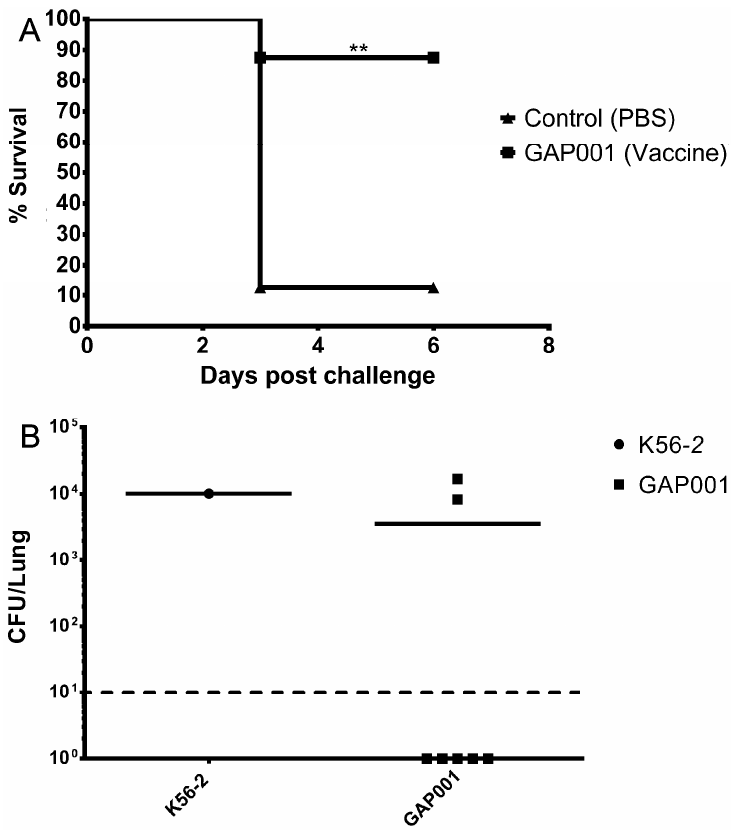
Figure 4. Immunization with GAP001 protects against challenge with B. cenocepacia. BALB/c mice immunized with 5 × 10 7 CFU of GAP001 showed protection against the challenge with B. cenocepacia and compared with the control group (PBS). ( A ) Survival curves for the vaccinated (squares) and non-vaccinated (triangles) mice. ( B ) Bacterial loads at 6 days post infection for the vaccinated (squares) and non-vaccinated (triangles) mice. The limit of detection was 10 CFU/lung (horizontal dotted line). The Kaplan–Meier method was used and significant differences ( p ≤ 0.05) were calculated via a log rank test. Table 4. Serum antibody response of BALB/c mice i.n. vaccinated with B. cenocepacia live attenuated